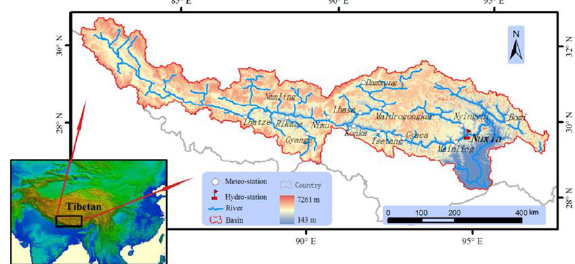
Figure 1. River network and locations of the Yarlung